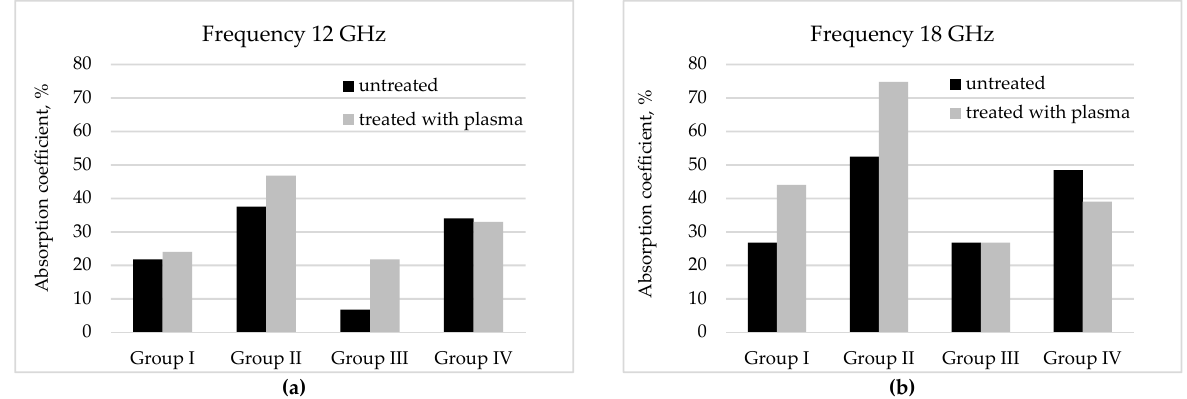
Figure 9. Absorption ability of tested samples: ( a )—at 12 GHz frequency and ( b )—at 18 GHz frequency.